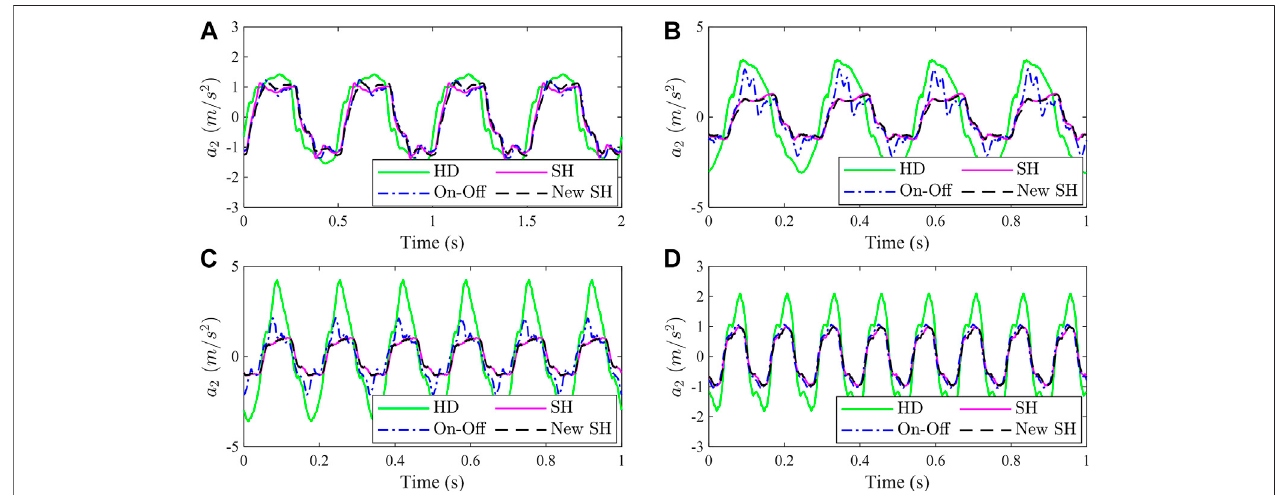
FIGURE 11 | Experimental results of sinusoidal displacement excitation: (A) 2 Hz, (B) 4 Hz, (C) 6 Hz, and (D) 8 Hz